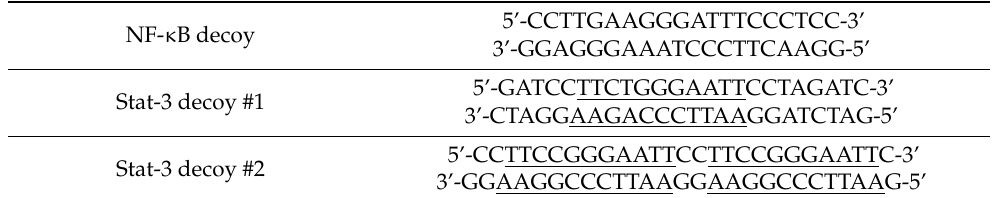
Table 1. Double-stranded decoy ODN